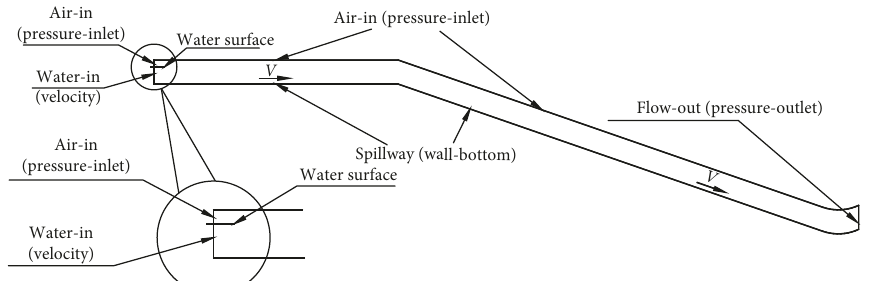
Figure 6: Definitions of the boundary conditions.